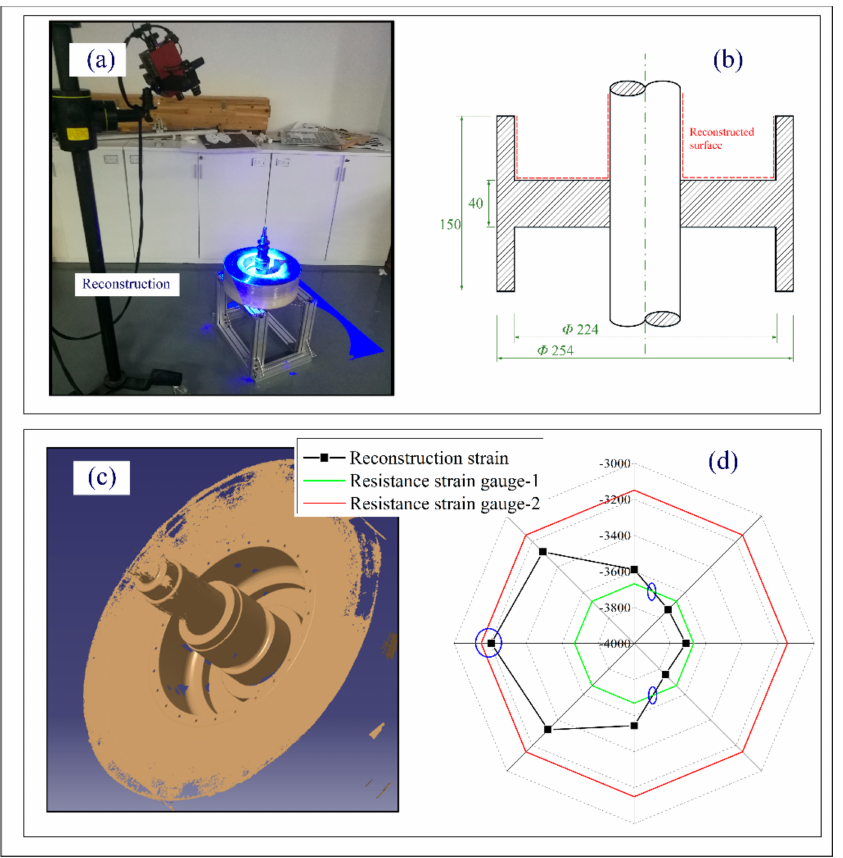
Figure 6. Offline strain collection: ( a ) reconstruction process; ( b ) reconstruction scheme; ( c ) recon- struction surface; and ( d ) comparison of online and offline